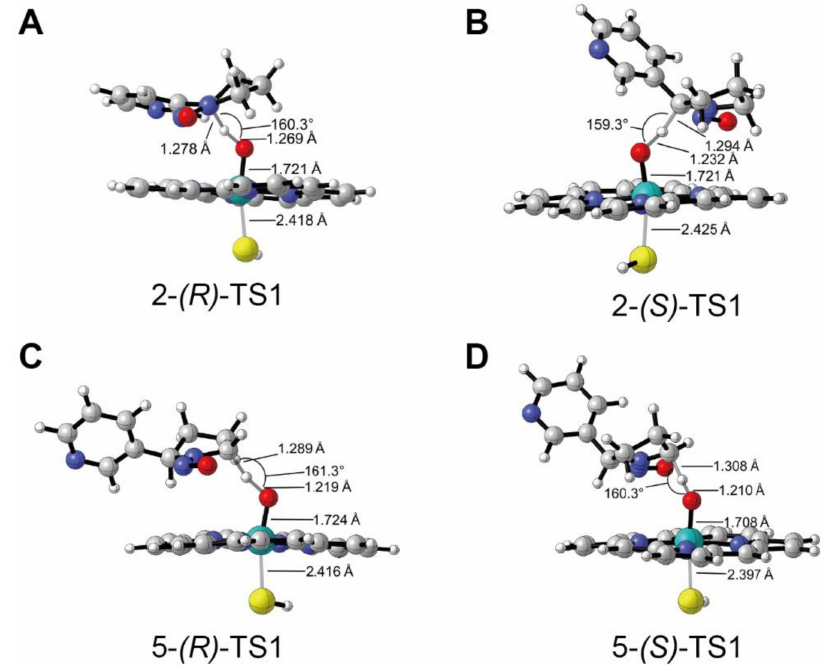
Figure 2. Optimized geometries and main parameters of the transition states of H-abstraction reactions for the 2 (cid:48) - and 5 (cid:48) -hydroxylation of ( R )-NNN and ( S )-NNN catalyzed by CYP450 CpdI. ( A ) Transition sate of 2 (cid:48) -hydroxylation of ( R )-NNN; ( B ) Transition sate of 2 (cid:48) -hydroxylation of ( S )-NNN; ( C ) Transition sate of 5 (cid:48) -hydroxylation of ( R )-NNN; ( D ) Transition sate of 5 (cid:48) -hydroxylation of ( S )-NNN (distances in angstroms). The red atom represents oxygen, the cyan atom represents Fe, the sliver atom represents hydrogen, and the gray atom represents